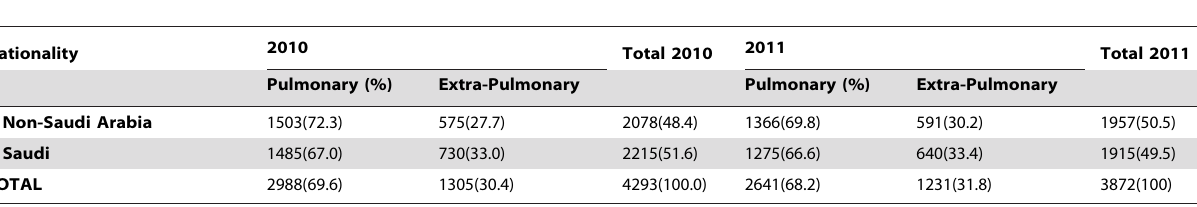
Table 1. The distribution of new TB cases by Pulmonary and Extra-Pulmonary among Saudis and Non-Saudis (2010–2011).